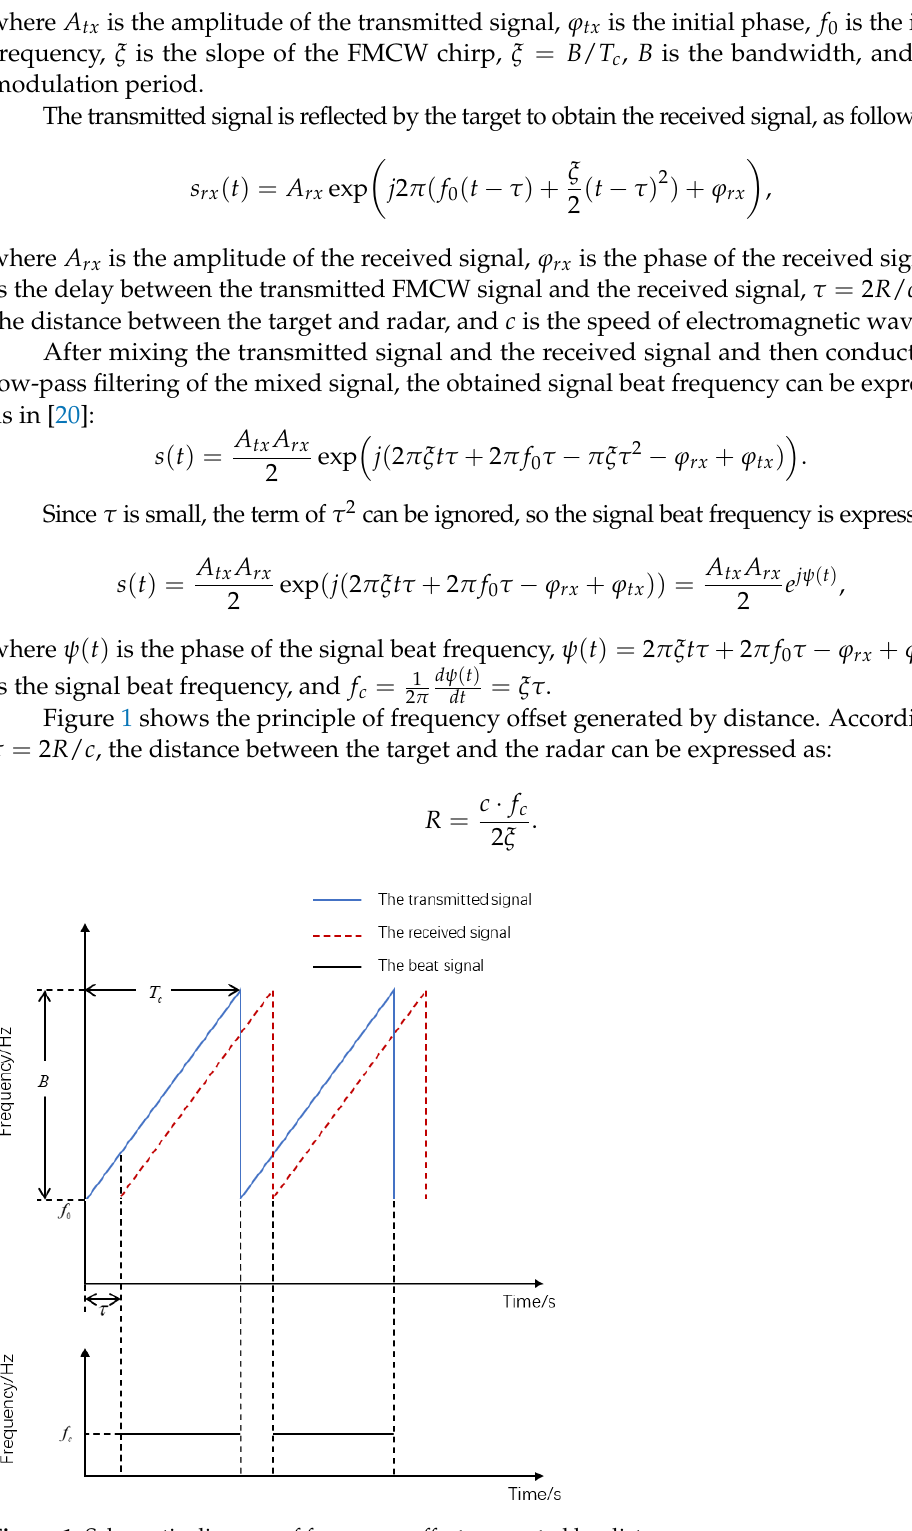
Figure 1. Schematic diagram of frequency offset generated by